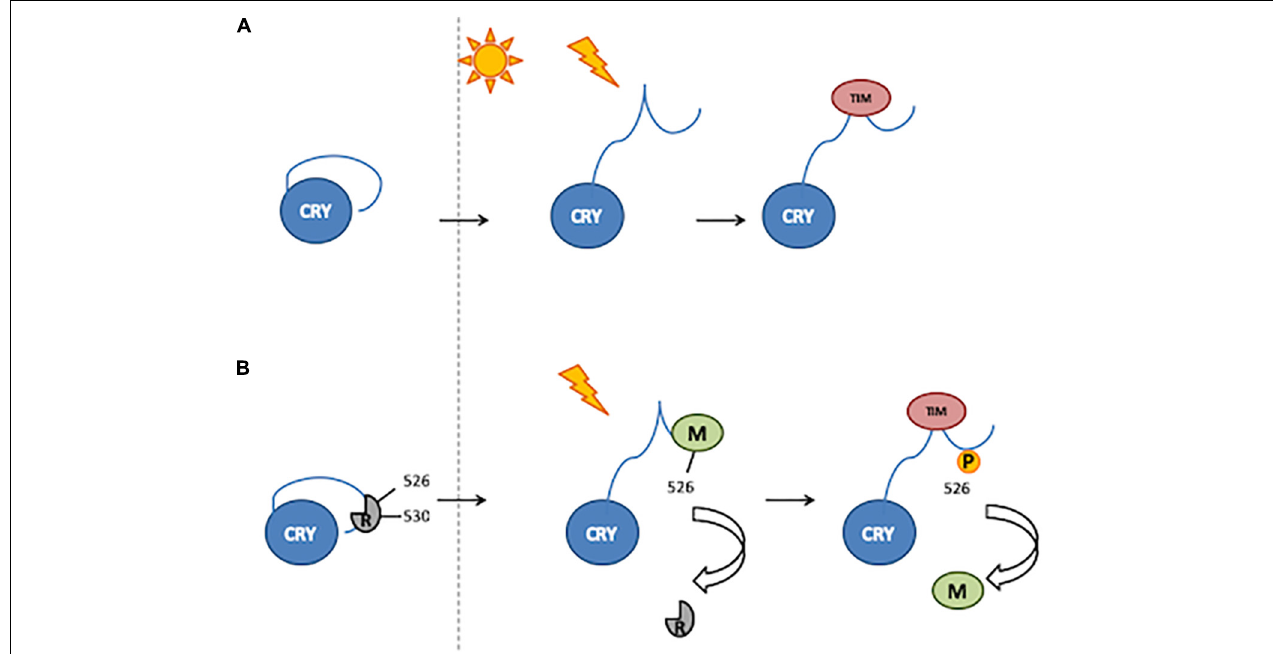
FIGURE 2 | Two mechanisms of CRY activation. (A) Light induces a conformational change resulting in the release of CTT, thus enabling TIM binding. (B) In the darkness, a putative repressor (R) binds to the 530 residue and blocks the 526 position. After light exposure, the repressor is released and a modulator (M) binds to the 526 position. Phosphorylation of the 526 residue is involved in modulator release and thus TIM binding.